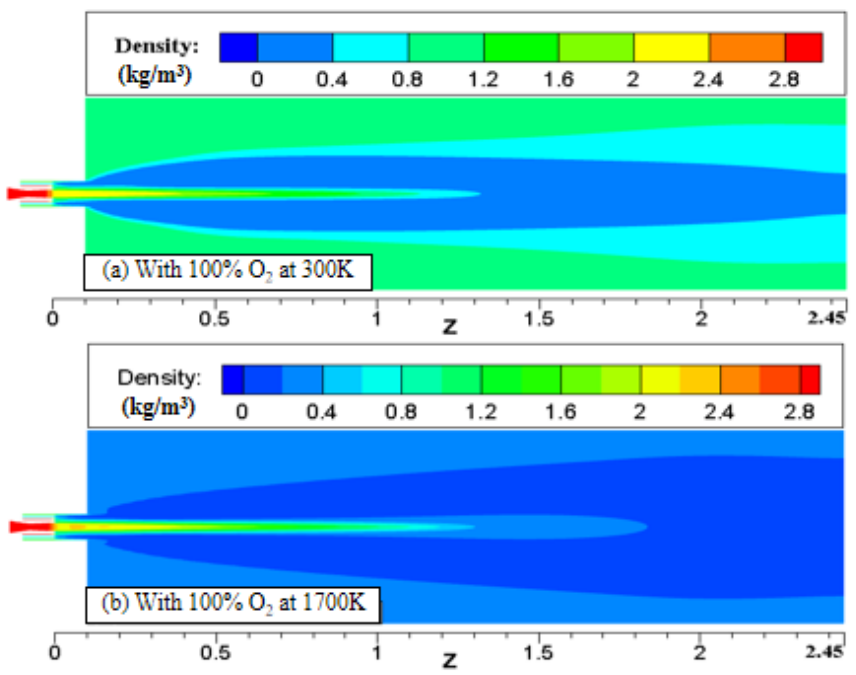
Figure 8. Density distribution of the full oxygen coherent supersonic jet at 300 and 1700 K. ( a ) The density distribution of the mixed injection jet at an ambient temperature of 300 K. ( b ) The density distribution of the mixed injection jet at an ambient temperature of 1700 K.